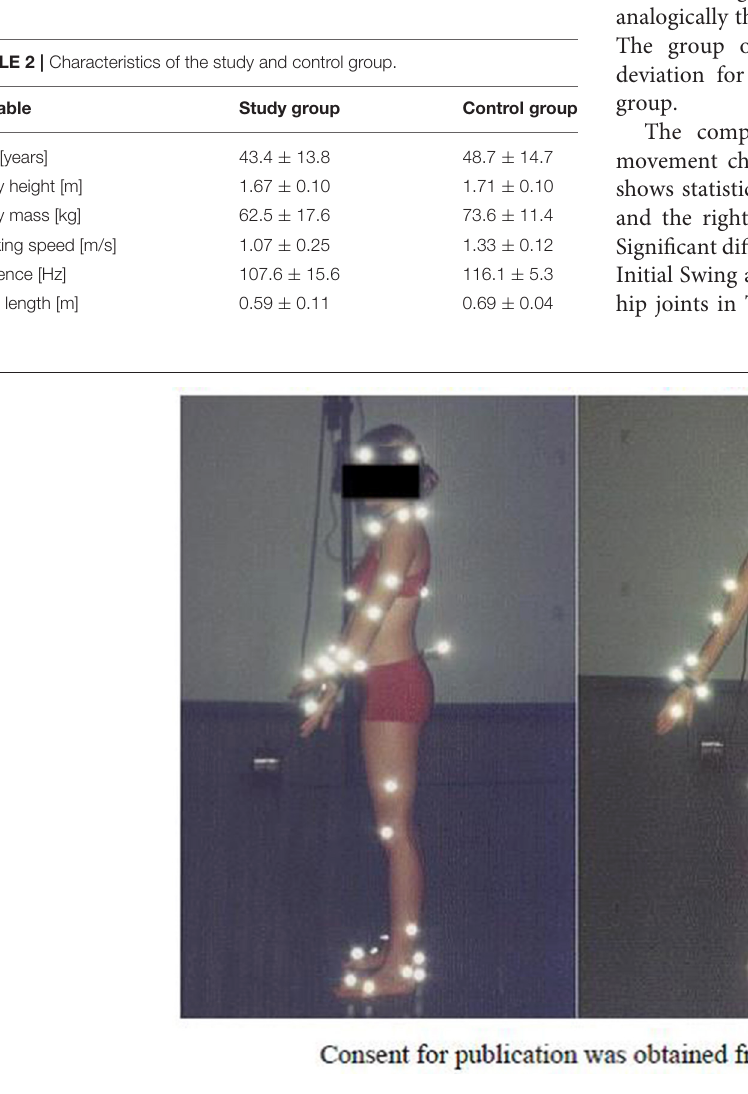
FIGURE 1 | Passive markers on the examined person (side and front